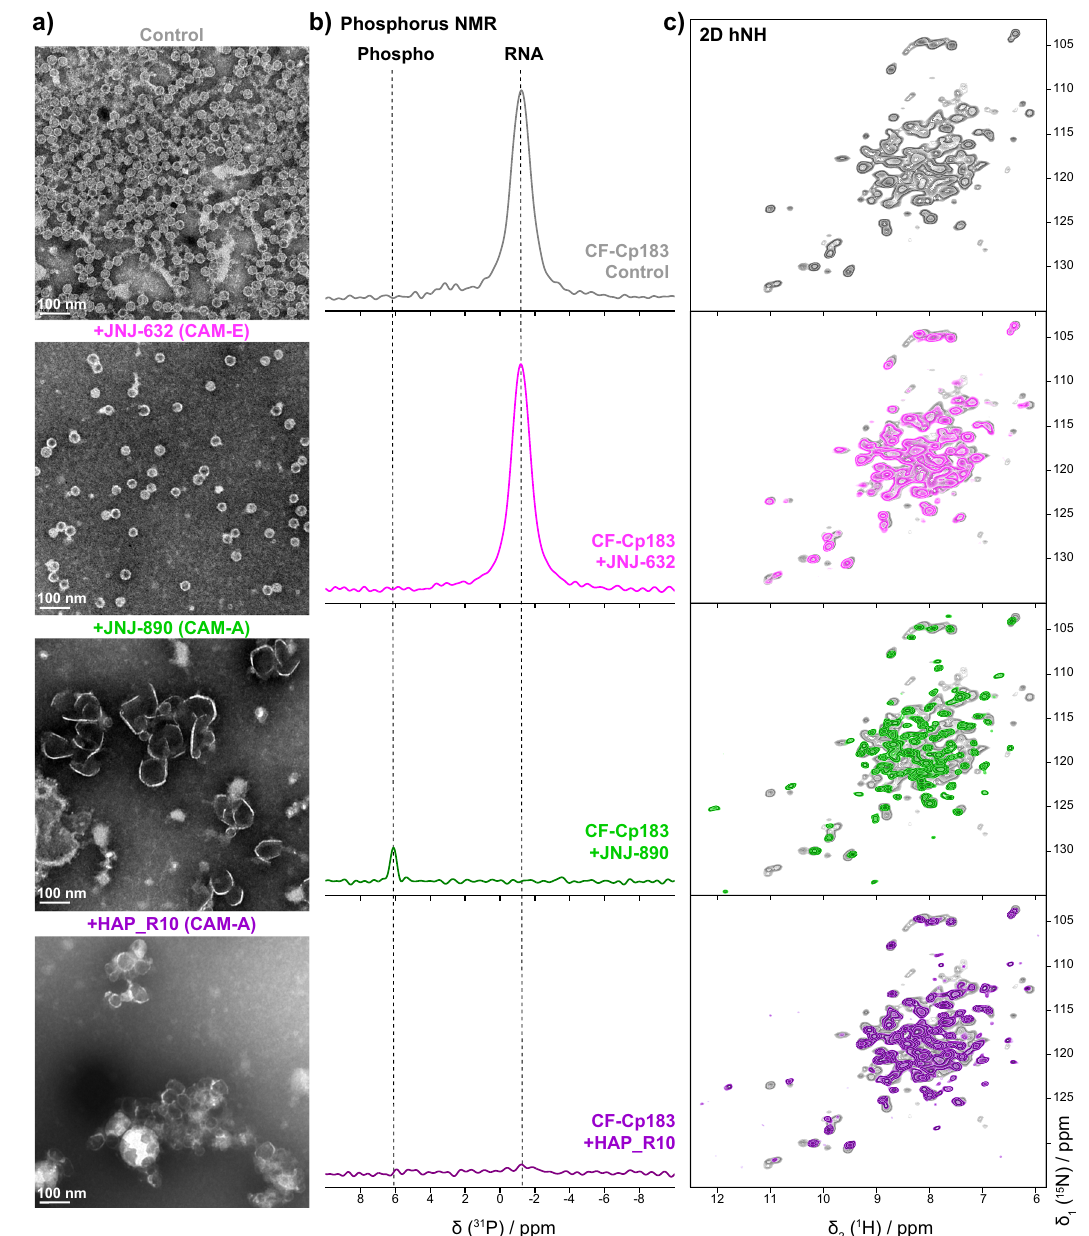
Fig. 4 | Effect of CAM-A and CAM-E on Cp183 CTD phosphorylation and RNA packaging. a Negative-staining EM micrographs of NMR samples of Cp183 from WG-CFPS as control. EM micrographs were taken on resuspended sediments after 1.3mm rotor fi lling (see corresponding SDS-PAGE in Supplementary Fig. 13). n =1 independent experiments have been recorded. b 1D 1 H- 31 P CP spectra of cell-free synthesized Cp183 (CF-Cp183) without CAM (gray), assembled in presence of 1